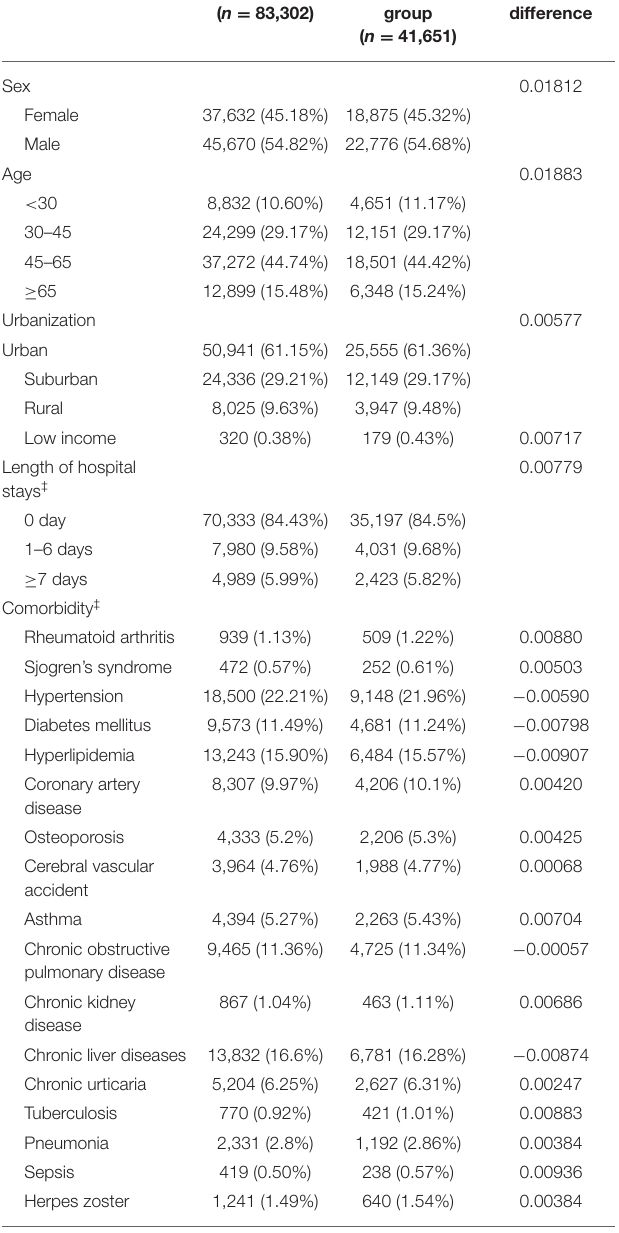
TABLE 2 | Systemic lupus erythematosus (SLE) incidence in patients with Helicobacter pylori (HP) infection and controls.